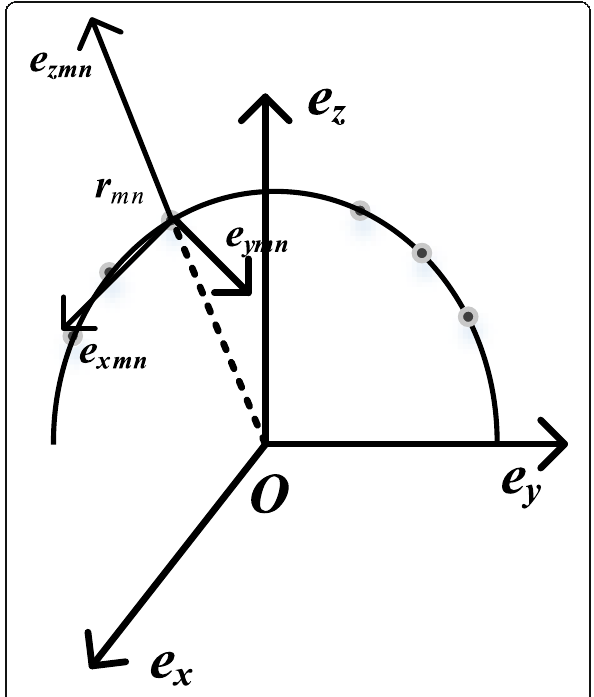
Fig. 4 The local coordinate of the ( m , n )th